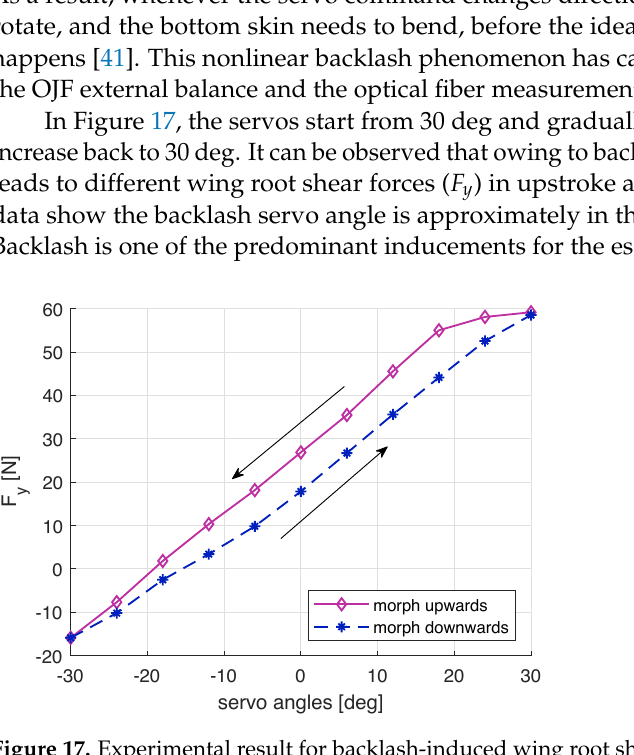
Figure 17. Experimental result for backlash-induced wing root shear force hysteresis